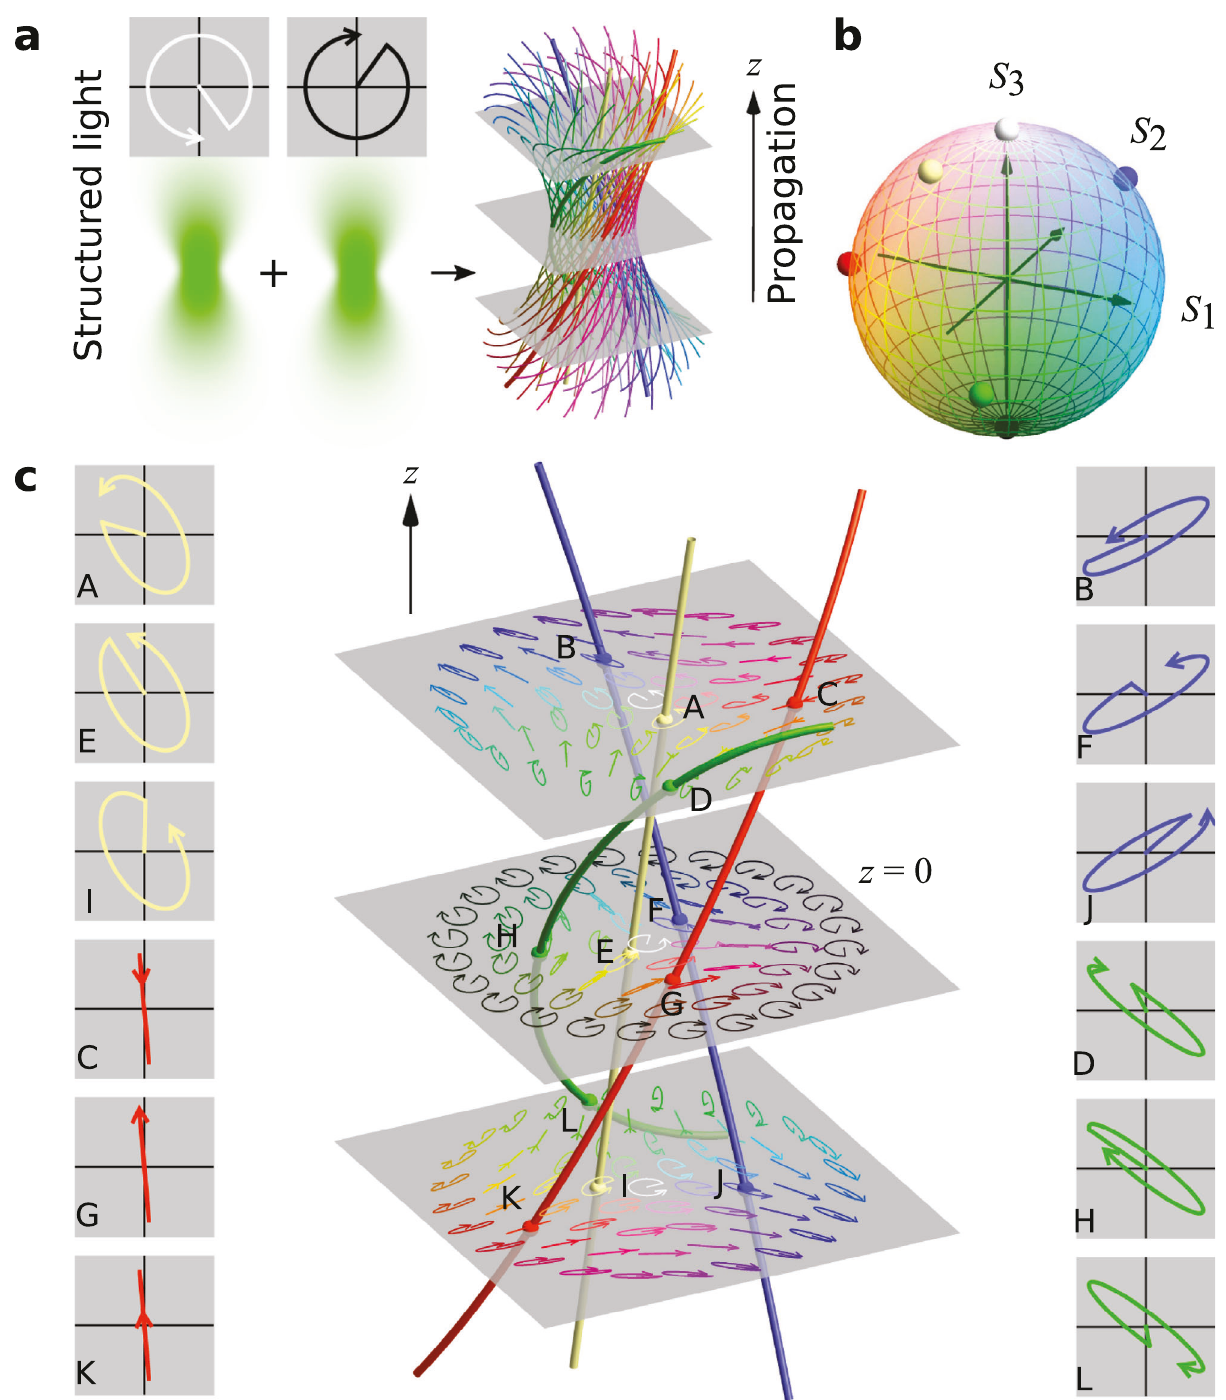
Fig. 1 3D optical polarisation texture. A light fi eld with position-dependent transverse polarisation and phase is created in a volume from the superposition of RH and LH circularly polarised beams, whose amplitude and phases are carefully structured. Spatial points characterised by the same state of elliptic polarisation lie on the fi laments ( a ). The 3D polarisation texture can be visualised by colouring the fi laments according to the position of its polarisation ellipse on the Poincaré sphere ( b ). The azimuthal angle α , representing the ellipse orientation, is coloured with the hues and the polar angle β , representing the ellipticity, is associated with the saturation levels. The sphere ’ s poles, representing the circular polarised states, are black (LH) and white (RH). Each optical state also has a phase, represented by the position of the arrow along the polarisation ellipse. In the transverse plane in ( c ), states of light are fully described by colours and arrowed ellipses. Along fi laments of constant polarisation, the phase on the ellipses varies smoothly, as shown in the insets for three representative